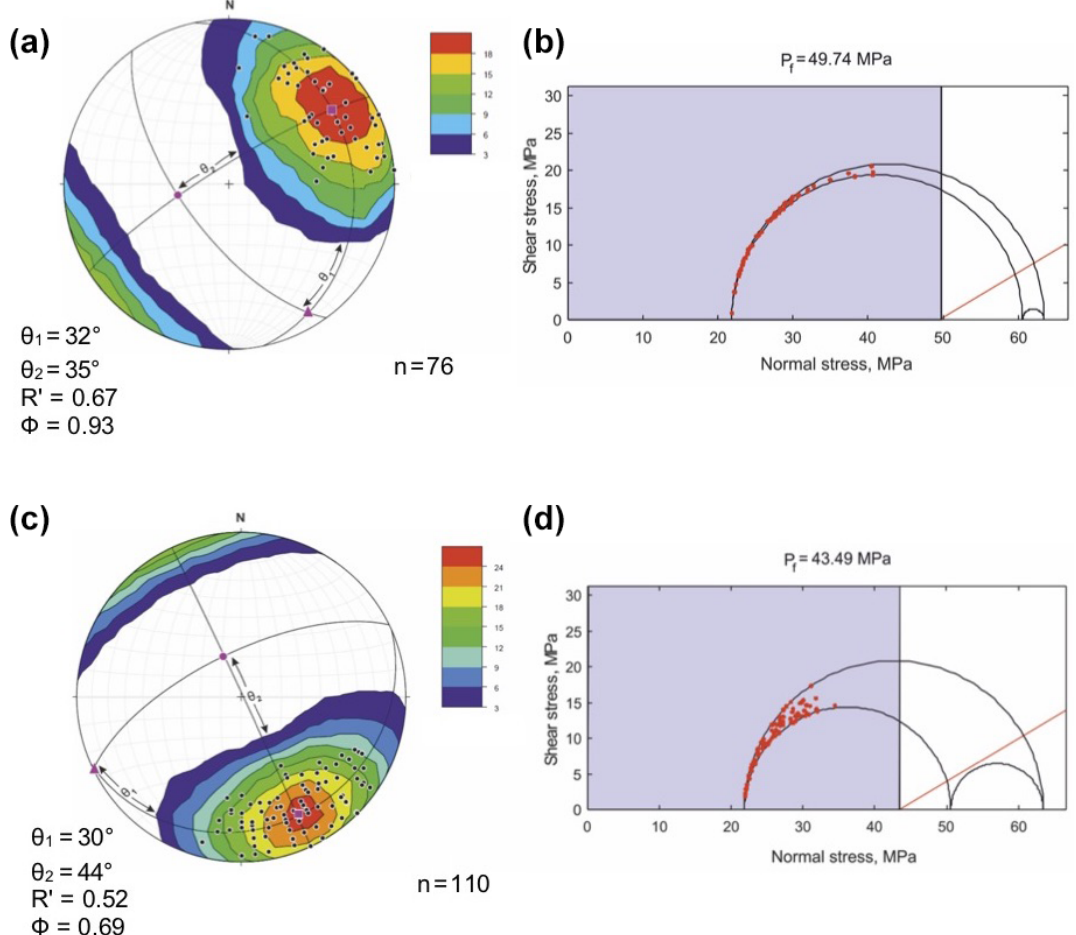
Figure 8. State of stress and fluid pressure ( P f ) conditions determined from the vein orientation data in the study area. (a) Lower hemisphere equal area projection of poles to vein data forming the NE cluster. (b) 3-D Mohr circle diagram for the NE cluster. (c) Lower hemisphere equal area projection of poles to vein data forming the SE cluster. (d) 3-D Mohr circle diagram for the SE cluster. In the respective lower hemisphere equal area projections, cluster distribution of vein pole data indicates P f < σ 2 . Cluster maxima define the σ 3 axis. The ranges of fracture orientations ( θ ) are measured. Subsequently, φ and R (cid:48) values are also determined similarly to Fig. 7. Pink circle ( σ 1 ), pink triangle ( σ 2 ) and pink square ( σ 3 ), respectively. In the 3-D Mohr circle diagrams, only a limited range of fractures filled up with veins are prone to reactivate. Red dots represent pole to vein data and red line forms the reactivation envelope for cohesionless fractures. Vein pole data lying within the blue zone, i.e., to the left of the P f (black) line, represent fractures filled up with veins that are prone to reactivate. n : number of